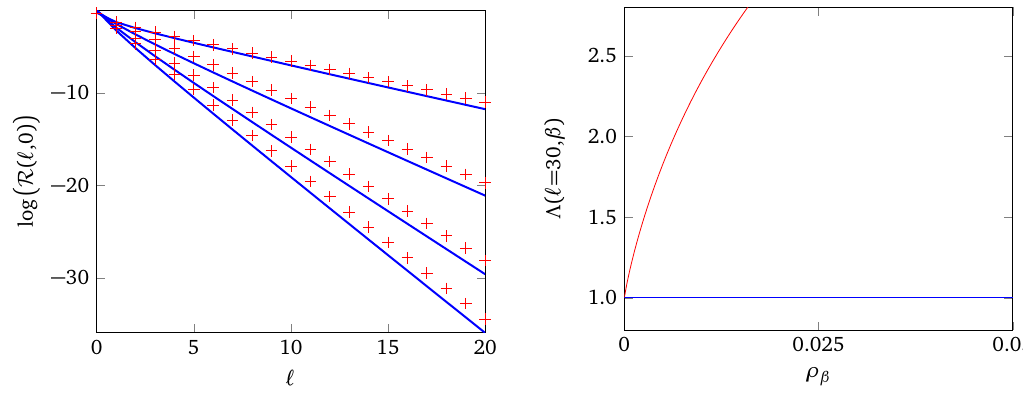
(cid:0) (cid:1) R ( (cid:96) ,0 ) Figure 14: Left: log as a function of (cid:96) for h = 1.5 and β = 2,0.5,0.285,0.2 from top to bottom. Numerical results for a L = 200 site open chain are shown as red crosses and equation (150) as straight blue lines. Right: numerical results for Λ ( (cid:96) = 30, β ) as a function of ρ = 3 / 2 (red line). The expected result when β for h ρ = 0 is shown in blue. β